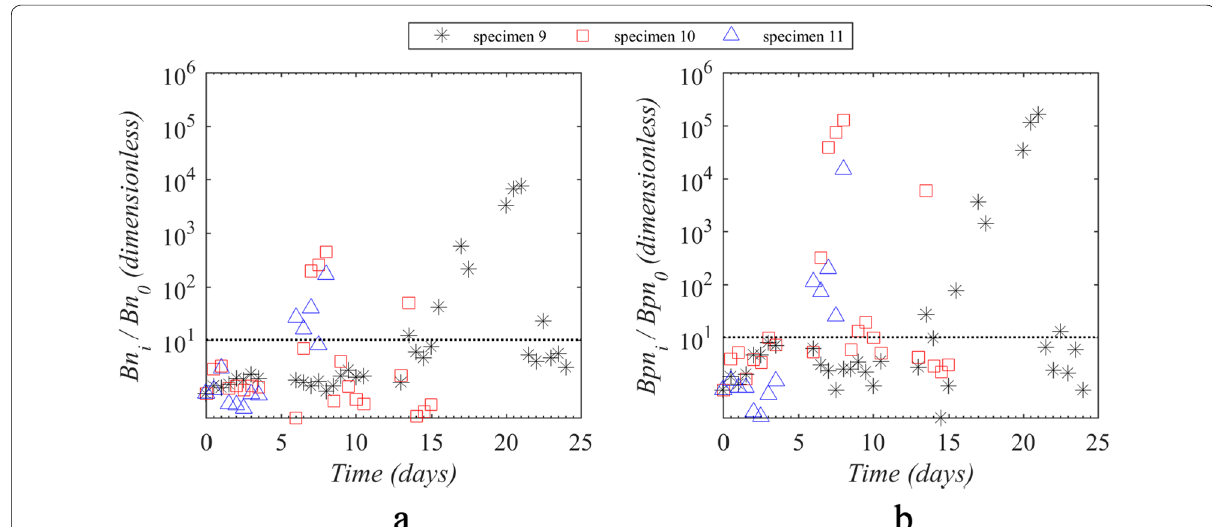
Fig. 12 Evolution of the parameters Bn and Bpn , normalized to their initial values ( t specimens (transducer emitter excited with 180 V). The dotted horizontal line represents the arbitrary threshold considered as indicative of a critical increase of the non‑linear elastic features, see text for